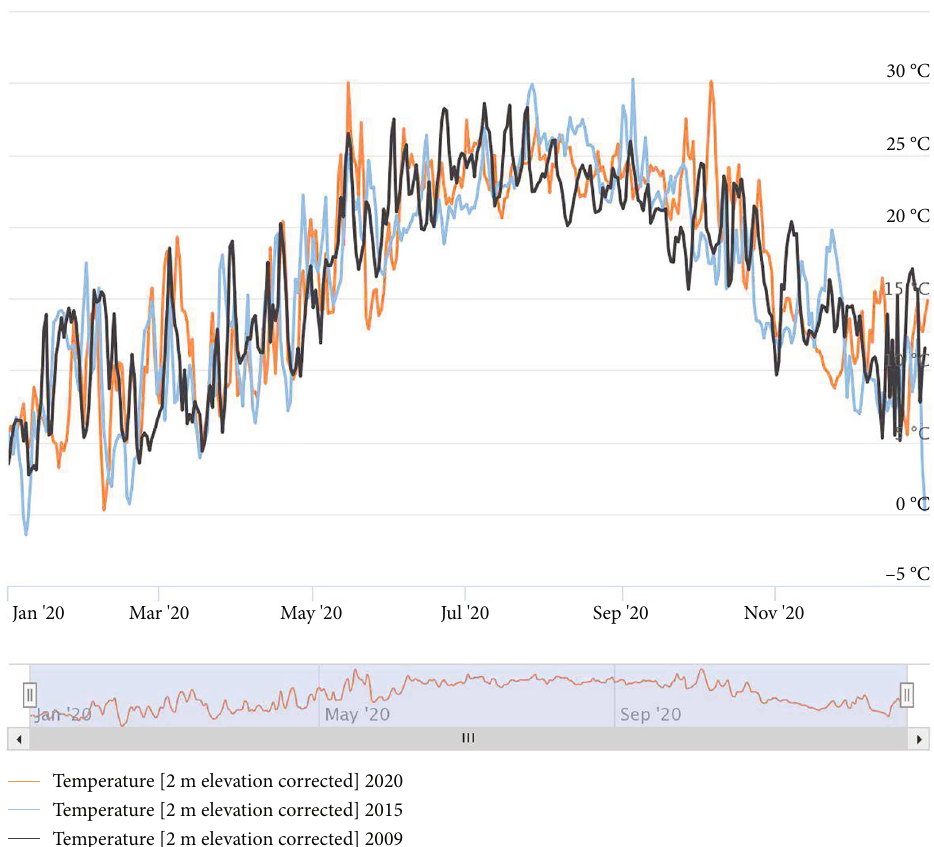
Figure 8: Annual mean daily temperature of years 2009, 2015, and 2020 for